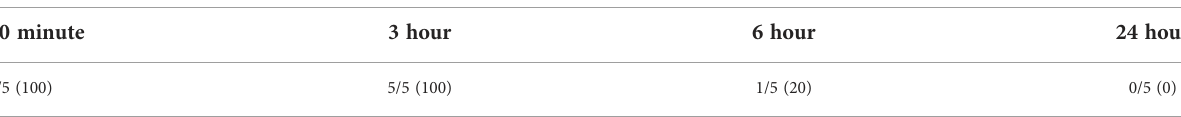
TABLE 1 Culture positive blood samples from time course with L. bi fl exa sv. Patoc. culture positive/total mice (%